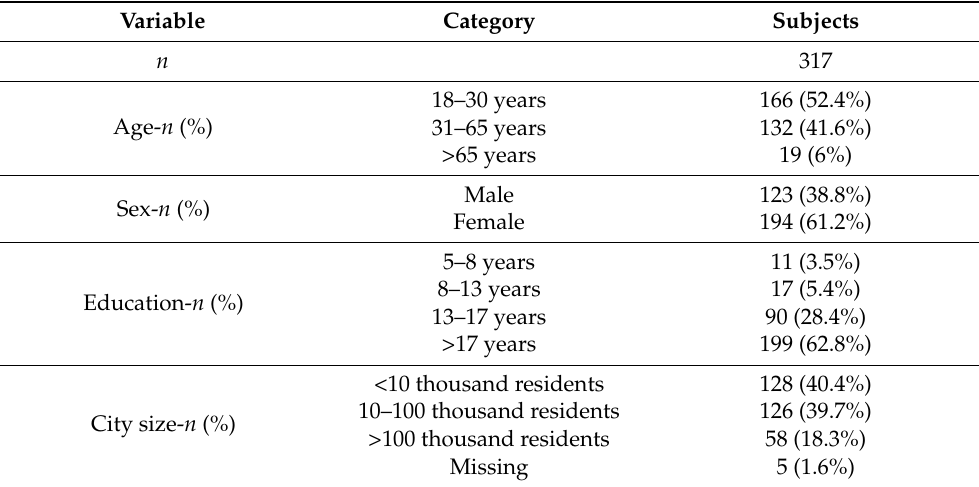
Table 1. Demographic characteristics of the